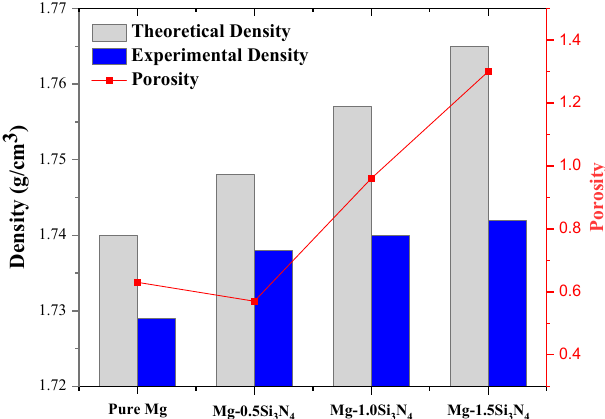
Figure 4. Density and porosity results of the samples.